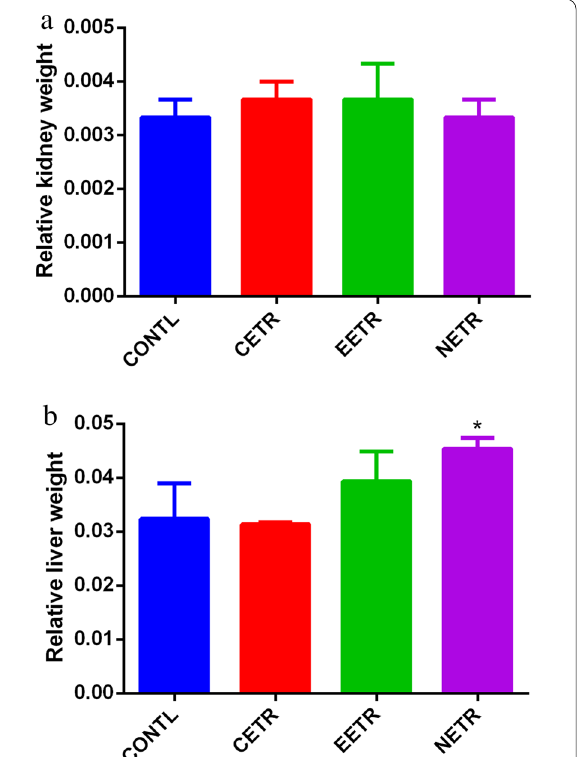
Fig. 1 The relative organ weights of the rats 14 days after single dose exposure to different extracts of Bombax costatum . a Kidneys and